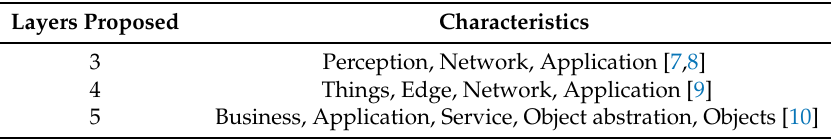
Table 1. IoT architecture: